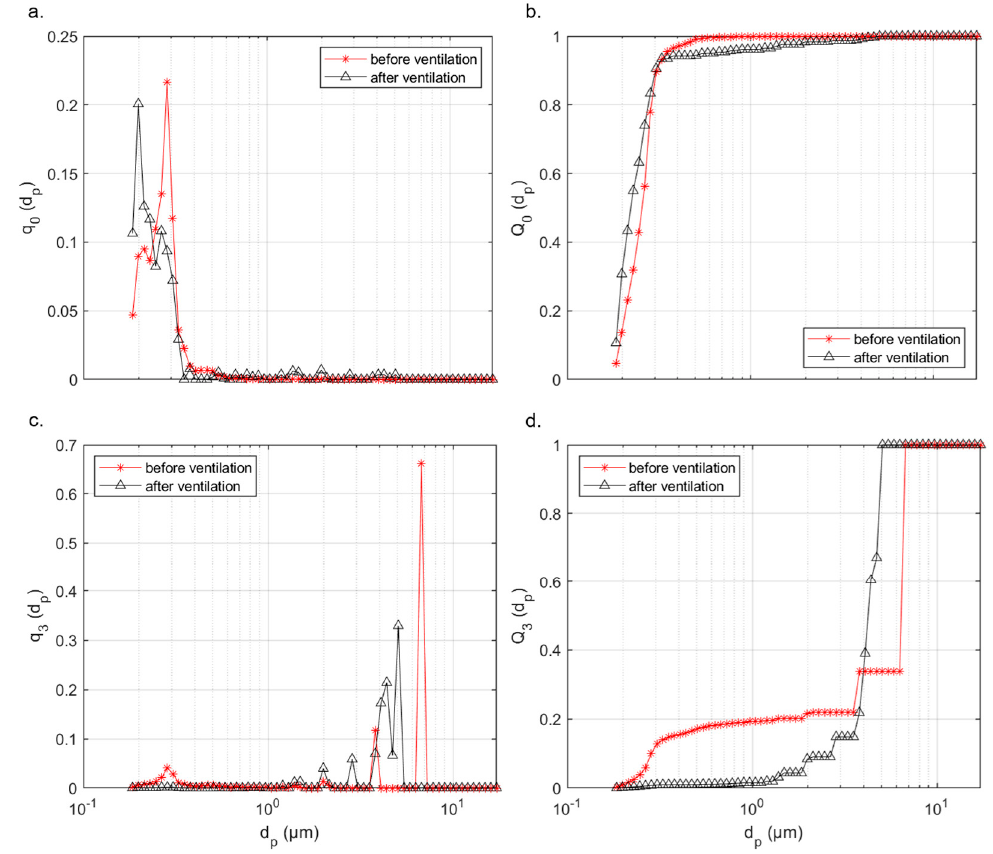
Figure 5. ( a ) Number-weighted density distribution q 0 and ( b ) cumulative curve Q 0 (upper diagrams) and ( c ) volume-weighted density q 3 and ( d ) cumulative curve Q 3 (lower diagrams) of the particle size ( d p ) distribution before (red) and after (black) 5 min of cross-ventilation.